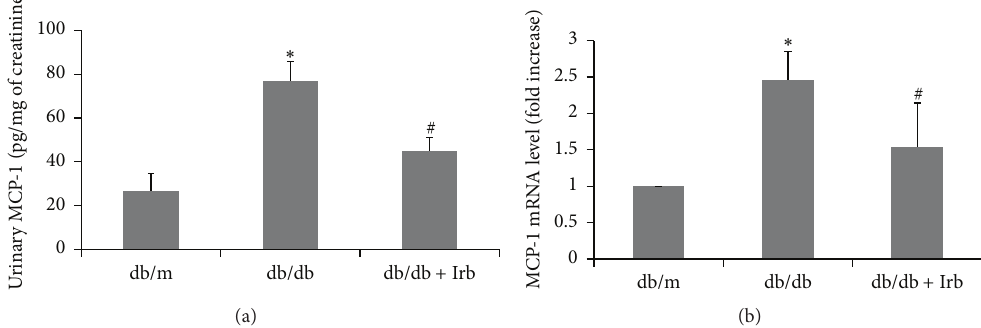
Figure 4: Irb attenuated diabetes-induced MCP-1 expression. (a) Urinary MCP-1 was significantly increased in db/db mice and significantly reduced in db/db mice with treatment of Irb. (b) The mRNA level of MCP-1 in the kidney was increased in the db/db mice and reversed by Irb treatment significantly. The bars in panels (a) and (b) show the mean expression in arbitrary units (error bars, S.D.). ∗ 𝑃 < 0.05 compared with db/m; # 𝑃 < 0.05 compared with db/db, 𝑡